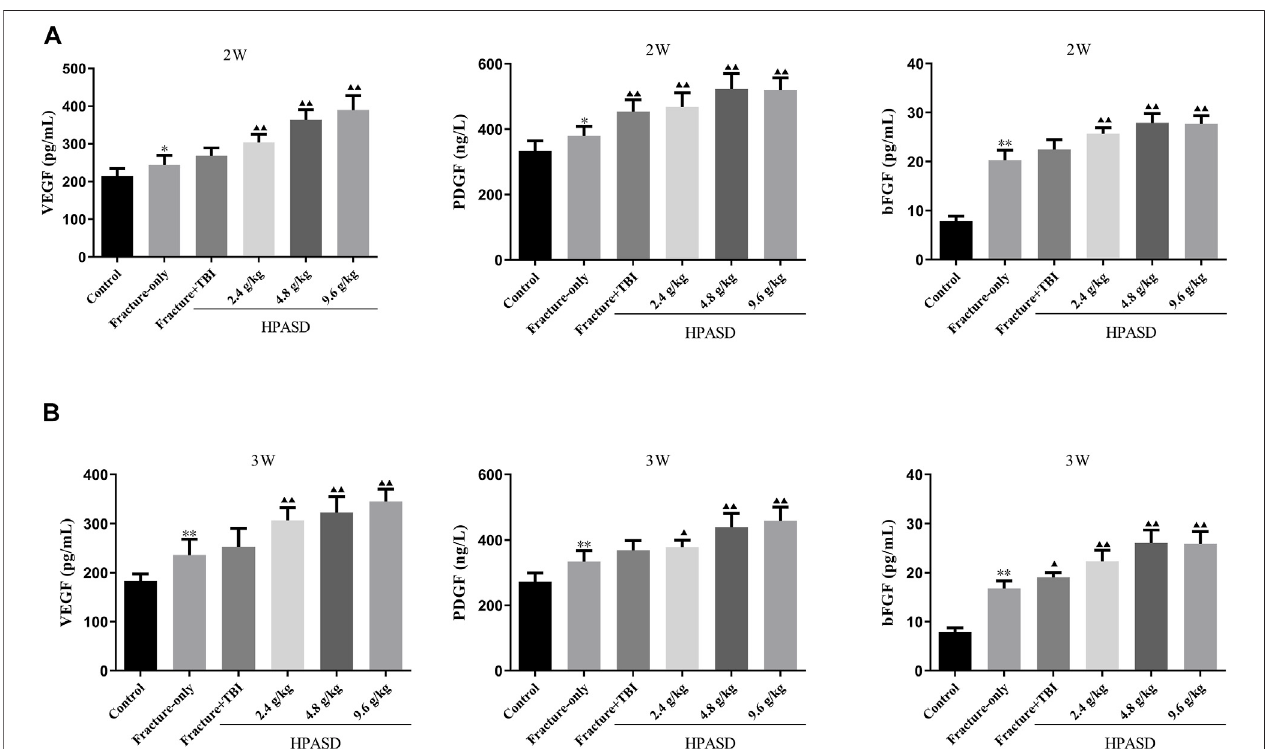
FIGURE7| HPASDpromotedtheVEGF,PDGF,andbFGFlevelsintheratmodeloftraumatic braininjury.TheconcentrationsofserumofVEGF,PDGF,andbFGF in the fracture rat model of traumatic brain injury at the (A) second and (B) third weeks after HPASD treatment were measured by ELISA assays, respectively. * p < 0.05 , ** p < 0.01 vs. Fracture-only group; ▲ p < 0.05 , ▲▲ p < 0.01 vs. Fracture + TBI group [unpaired Student ’ s